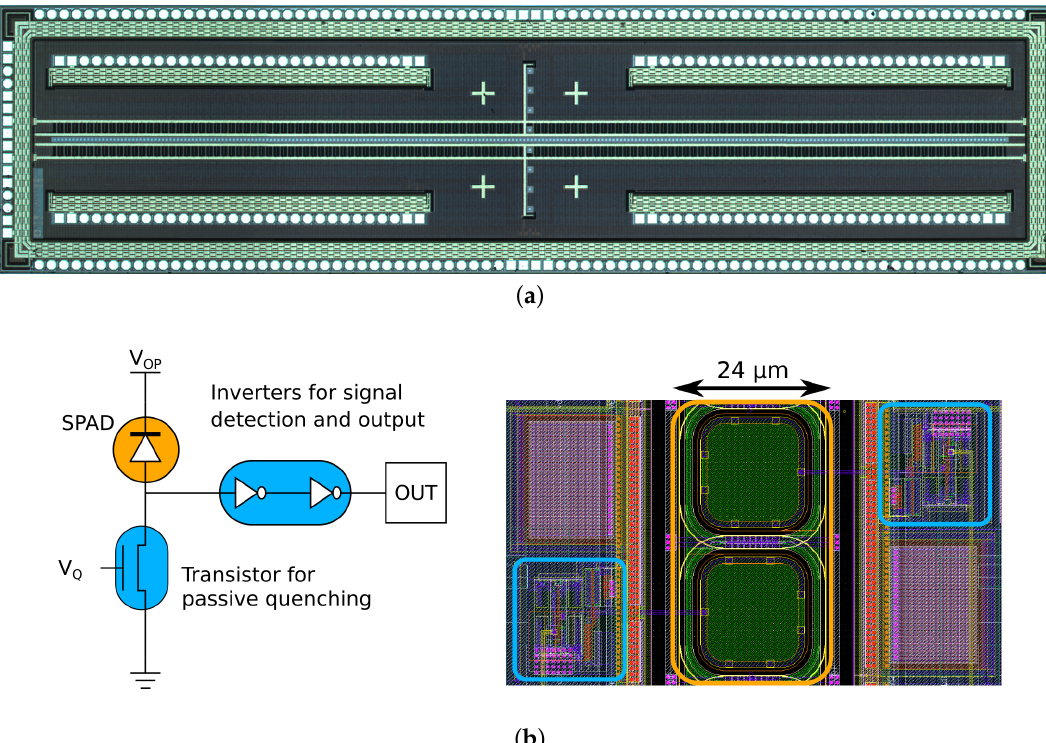
Figure 1. ( a ) Micrograph of the 6.8 mm by 1.7 mm LinoSPAD sensor. A total of 312 I/Os are laid out around the main line of pixels. Eight auxiliary pixels (with application specific pitch) and four alignment marks can be seen in the center; ( b ) Schematic of a single pixel and corresponding layout for a pair of pixels showing the alternating placement of pixel logic next to the densely packed diodes. The active area of the sensor corresponds to 40% of the highlighted SPAD (single-photon avalanche diode)